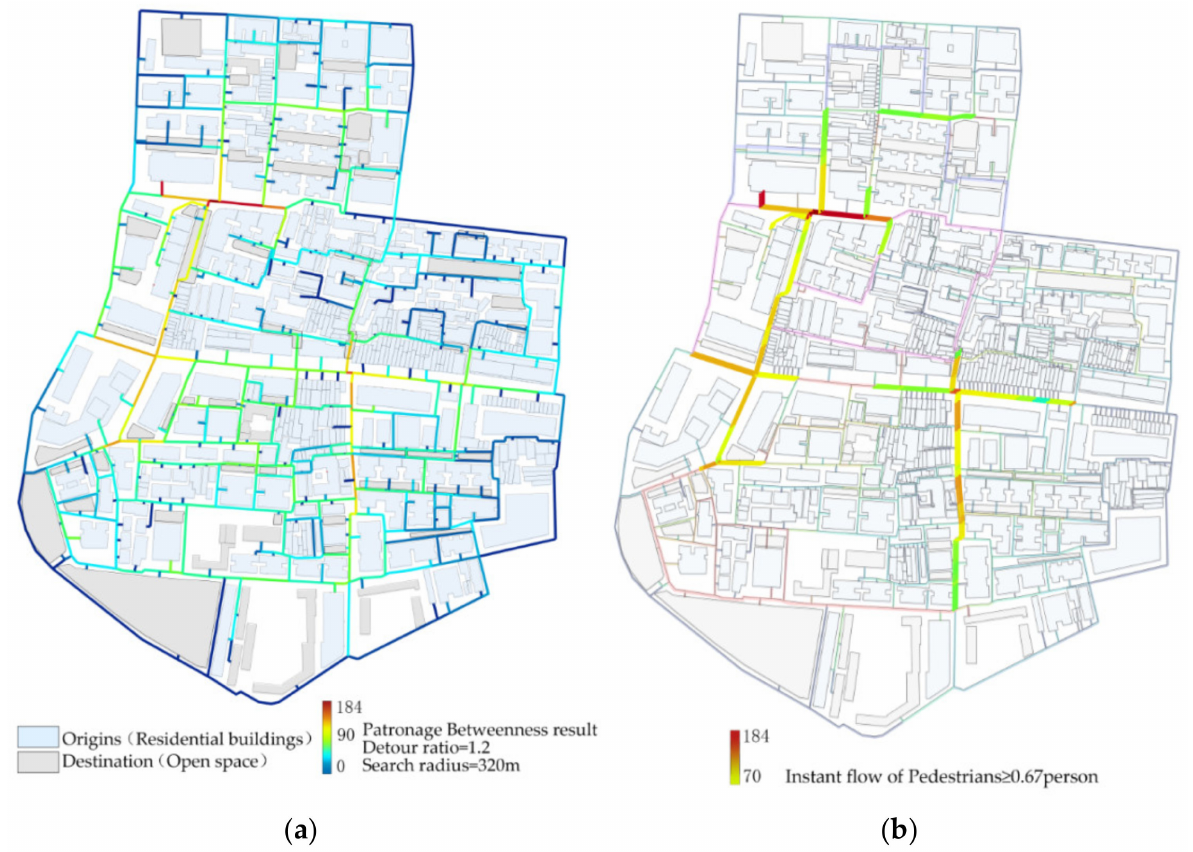
Figure 13. ( a ) Pedestrian flow rates of the elderly people; ( b ) crowded pedestrian route for the elderly